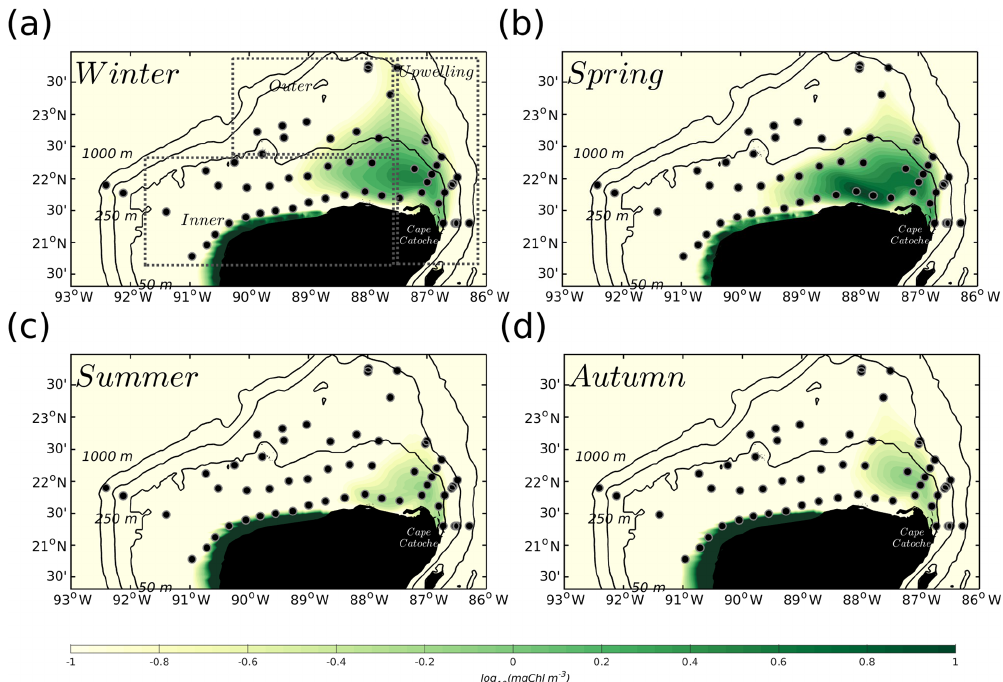
Figure 2. Seasonal climatology of surface chlorophyll (mgChlm − 3 ) given by the biogeochemical coupled model for (a) winter (January, February, March), (b) spring (April, May, June), (c) summer (July, August, September), and (d) autumn (October, November, December), for the 2002–2010 period. Dashed boxes in (a) denote the three areas in which the validation with observations (black dots) was carried out, i.e. inner shelf, outer shelf, and the upwelling region close to Cape